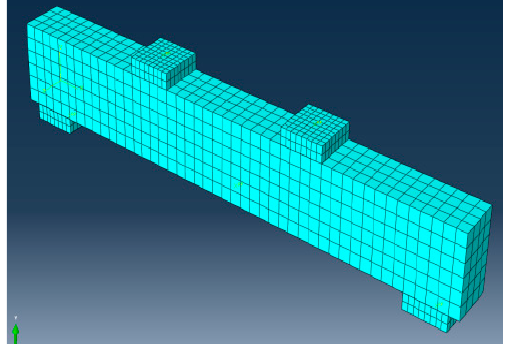
Figure 13. Mesh generation.